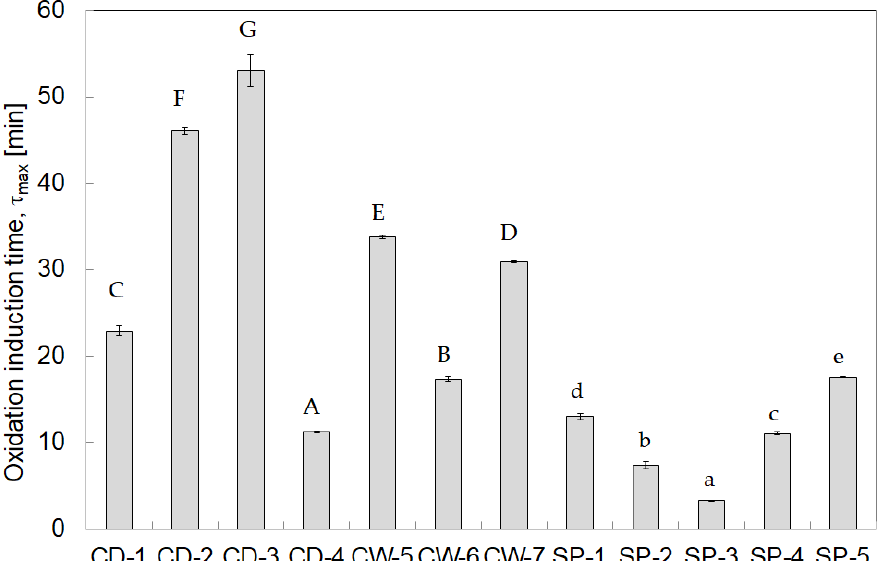
Figure 3. The oxidation induction time at 100 ◦ C obtained for the lipid fraction extracted from commercial and self-prepared cat foods. Different letters indicate that the samples are significantly different at p < 0.05 (the upper cases (A–G) for commercial cat foods and the lower cases (a–e) for self-prepared